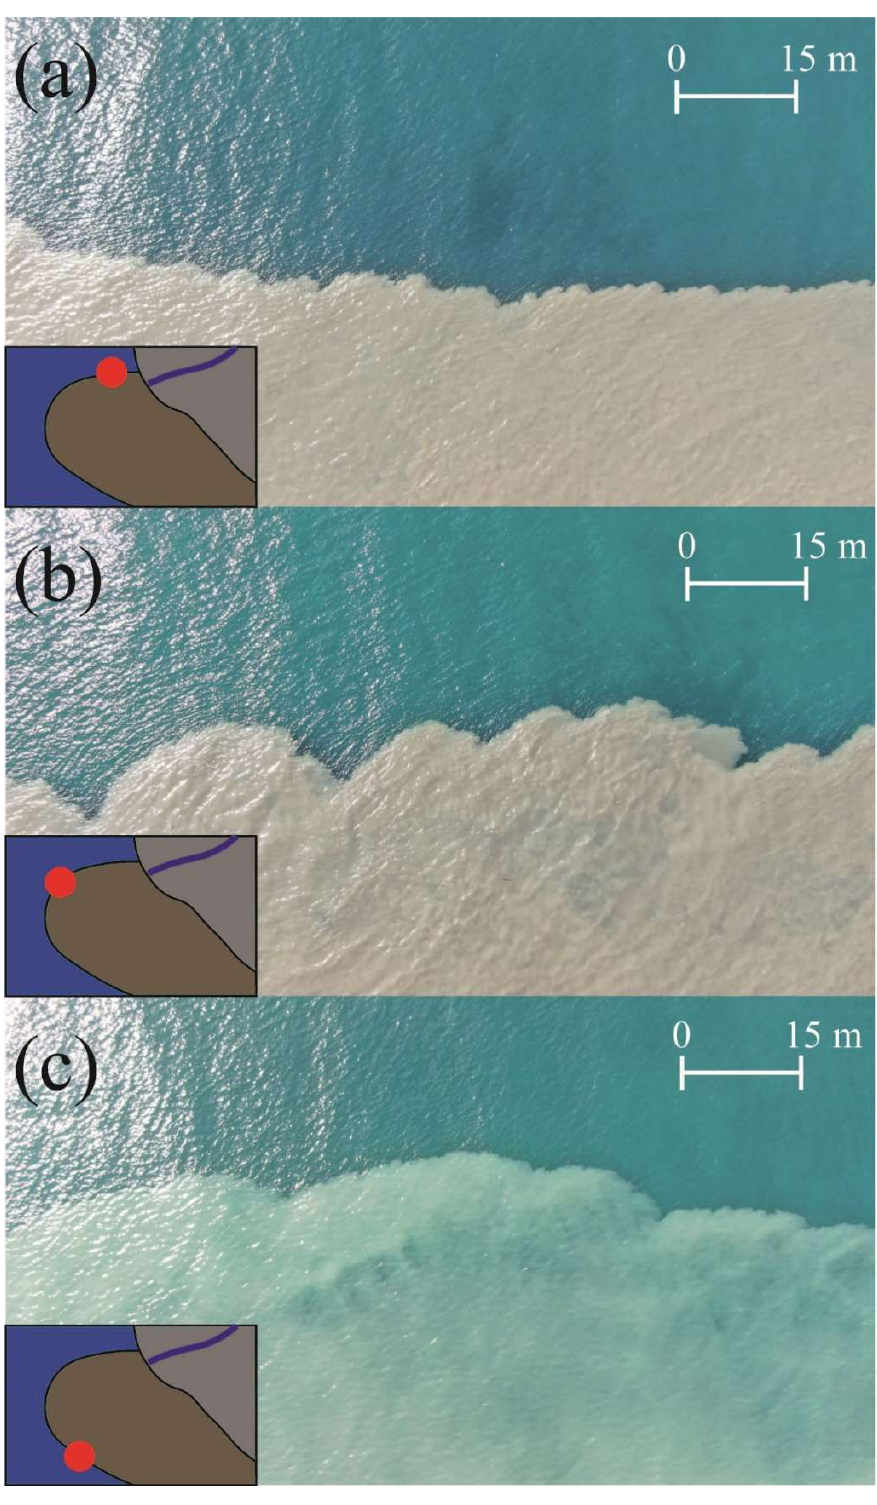
Figure 3. Aerial images of different parts of the Bzyb plume border on 28 April 2022 on distances of ( a ) 50 m, ( b ) 150 m, and ( c ) 400 m along the border from the river mouth illustrating different spatial scales of frontal instabilities. Red circles at the insets indicate segments of the plume border visible at the respective aerial images.